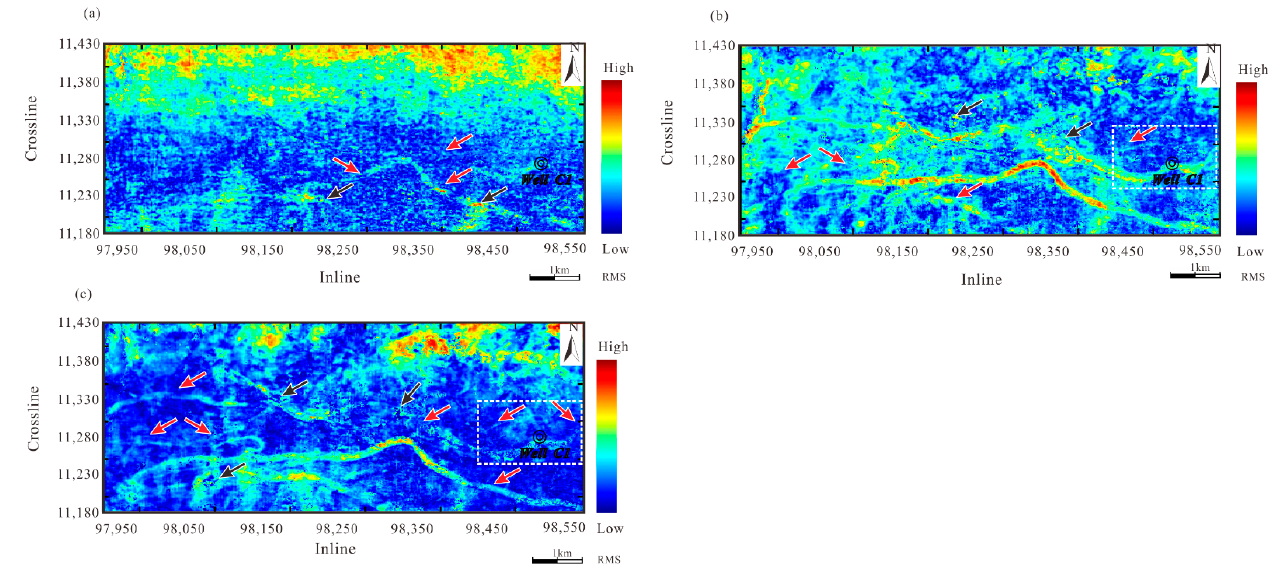
Figure 10. The RMS amplitude slices at t = 1650 ms. ( a – c ) show three decomposed components from the VMD method: ( a ) IMF1; ( b ) IMF2; ( c ) IMF3.